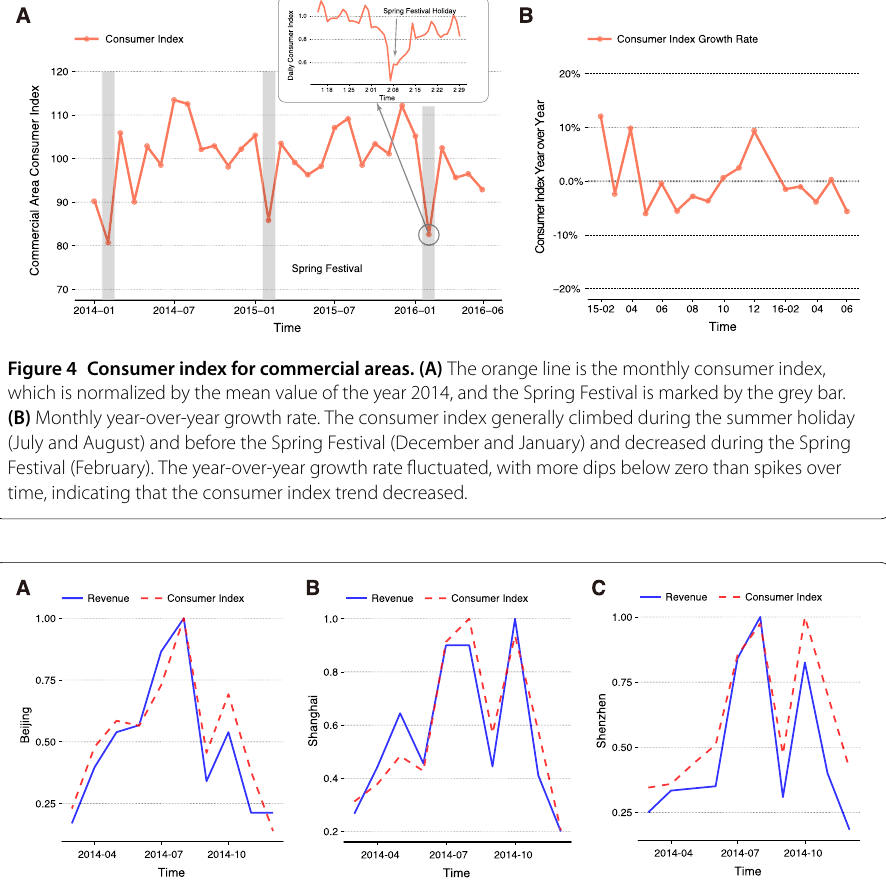
Figure 5 Consumer index and revenue. (A) Commercial area I at Beijing. (B) Commercial area II at Shanghai. (C) Commercial area III at